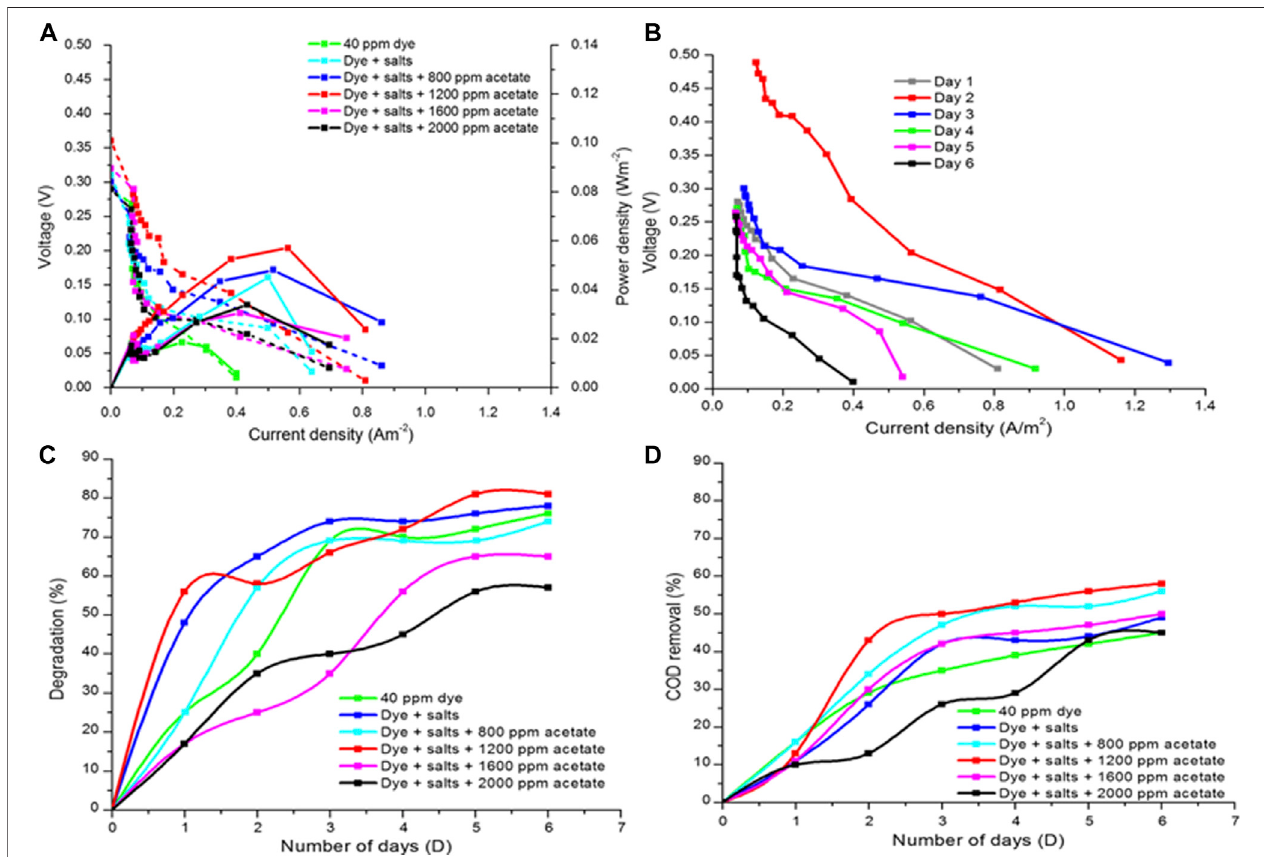
FIGURE 8 | (A) MFCI-5 curves measured 1 st day with 40 ppm dye and 800 – 2000 ppm acetate loading, with and without 2% salt addition (B) Performance development for each day after constant load at 100 ohm operation with circulating anolyte for an MFC with 40 ppm dye, 1200 ppm acetate, and 2% salt addition (NaCl+Na2SO4) (C) Percentage decolourisation of AO5 from UV-vis for the curves in (B) and (D) percentage of COD removal ovet